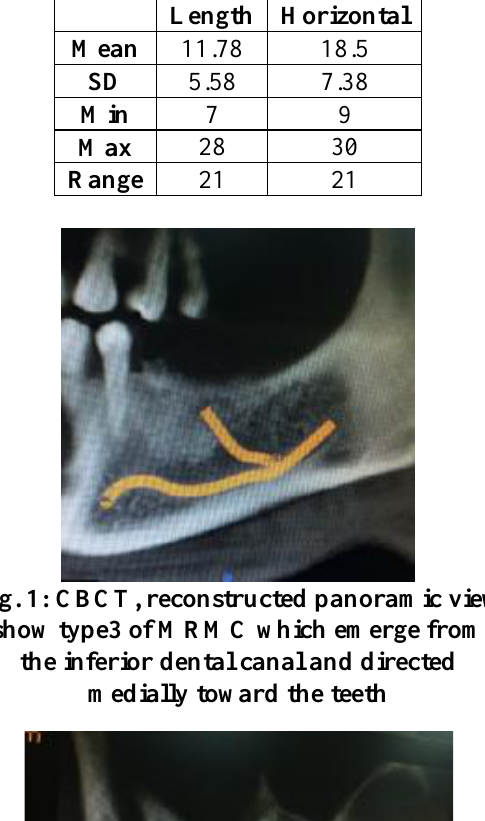
Table 6: Length (vertical) of MRMC, and Horizontal distance (mm) linear measurements